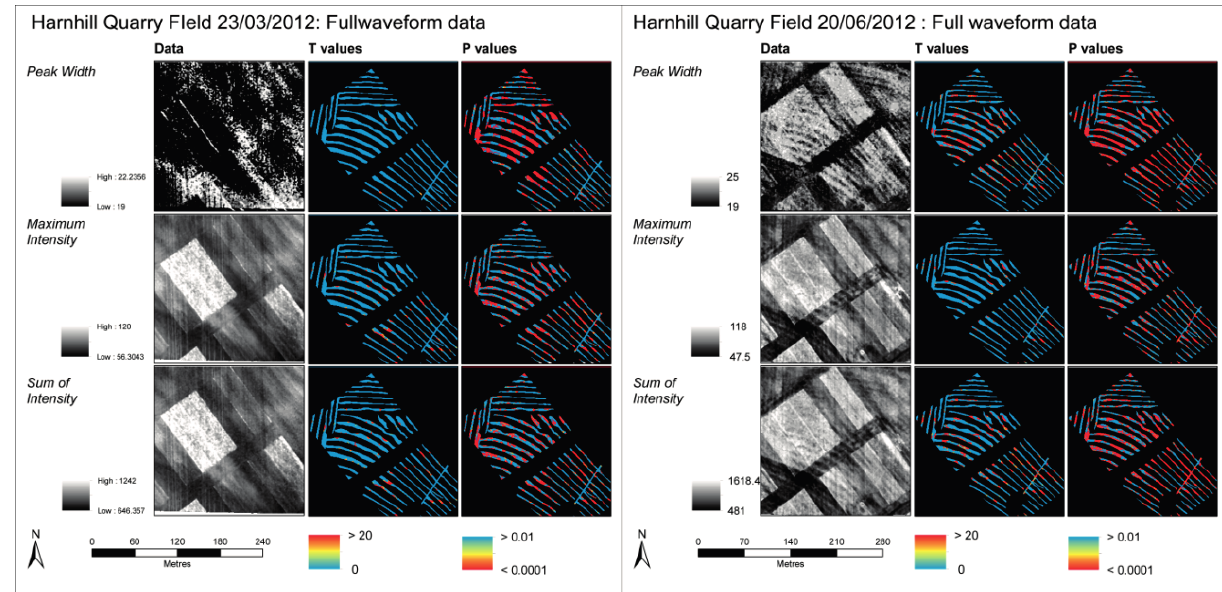
Figure 13. Metrics from airborne LiDAR full waveform data for Harnhill Quarry field and T -values and P -values indicating localised contrast.